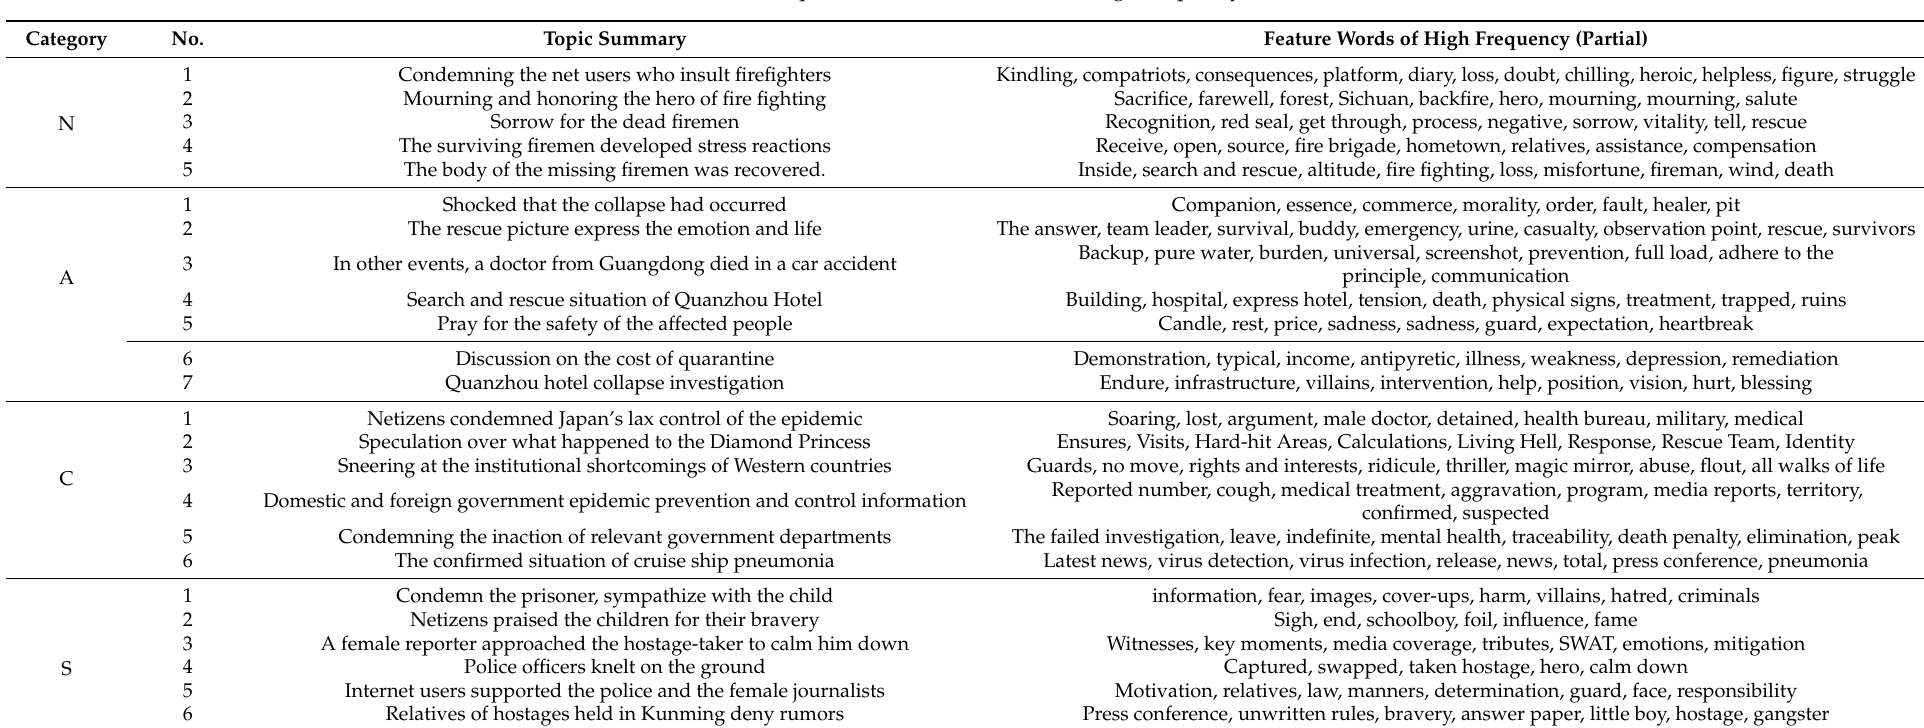
Table 5. Topics and the feature words of high